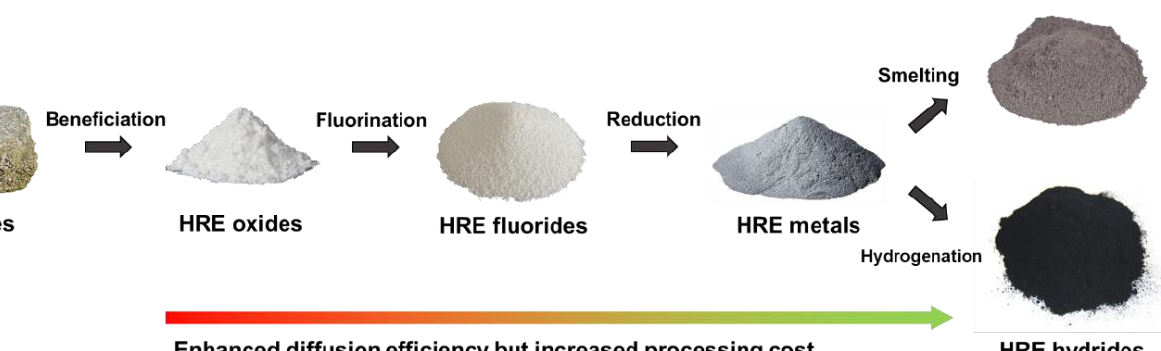
Figure 2. Fabrication steps of the HRE-based diffusion sources.